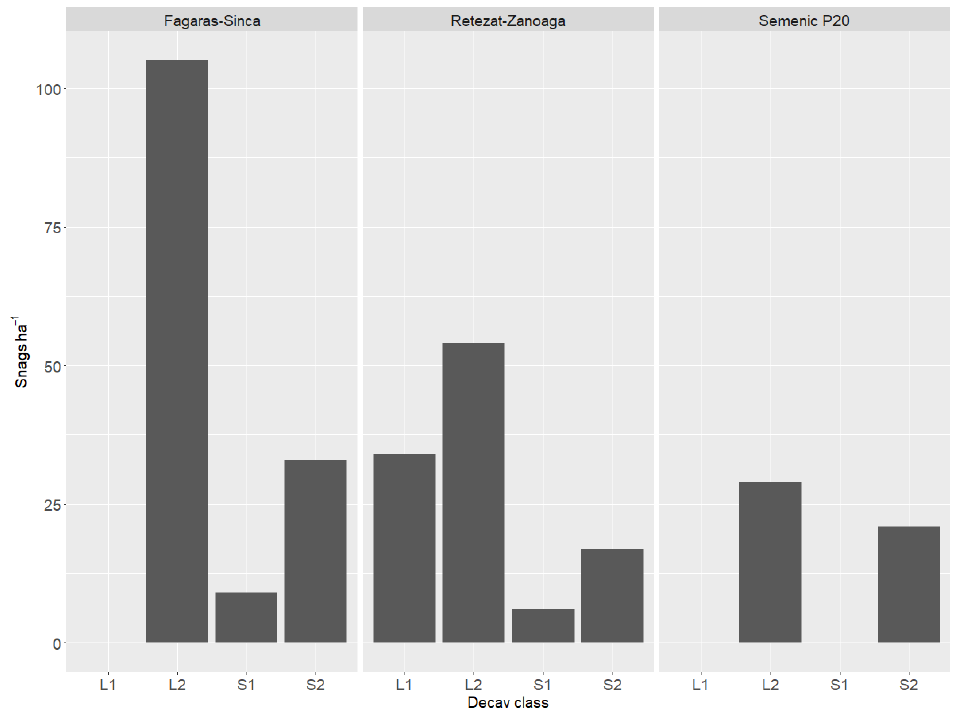
Figure 2. Dead wood distribution in relation to decay class.